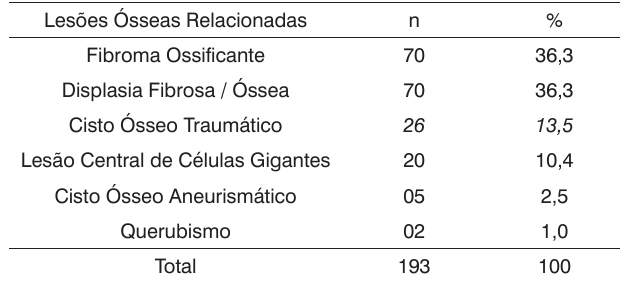
Tabela 1. Distribuição das Lesões Ósseas Relacionadas